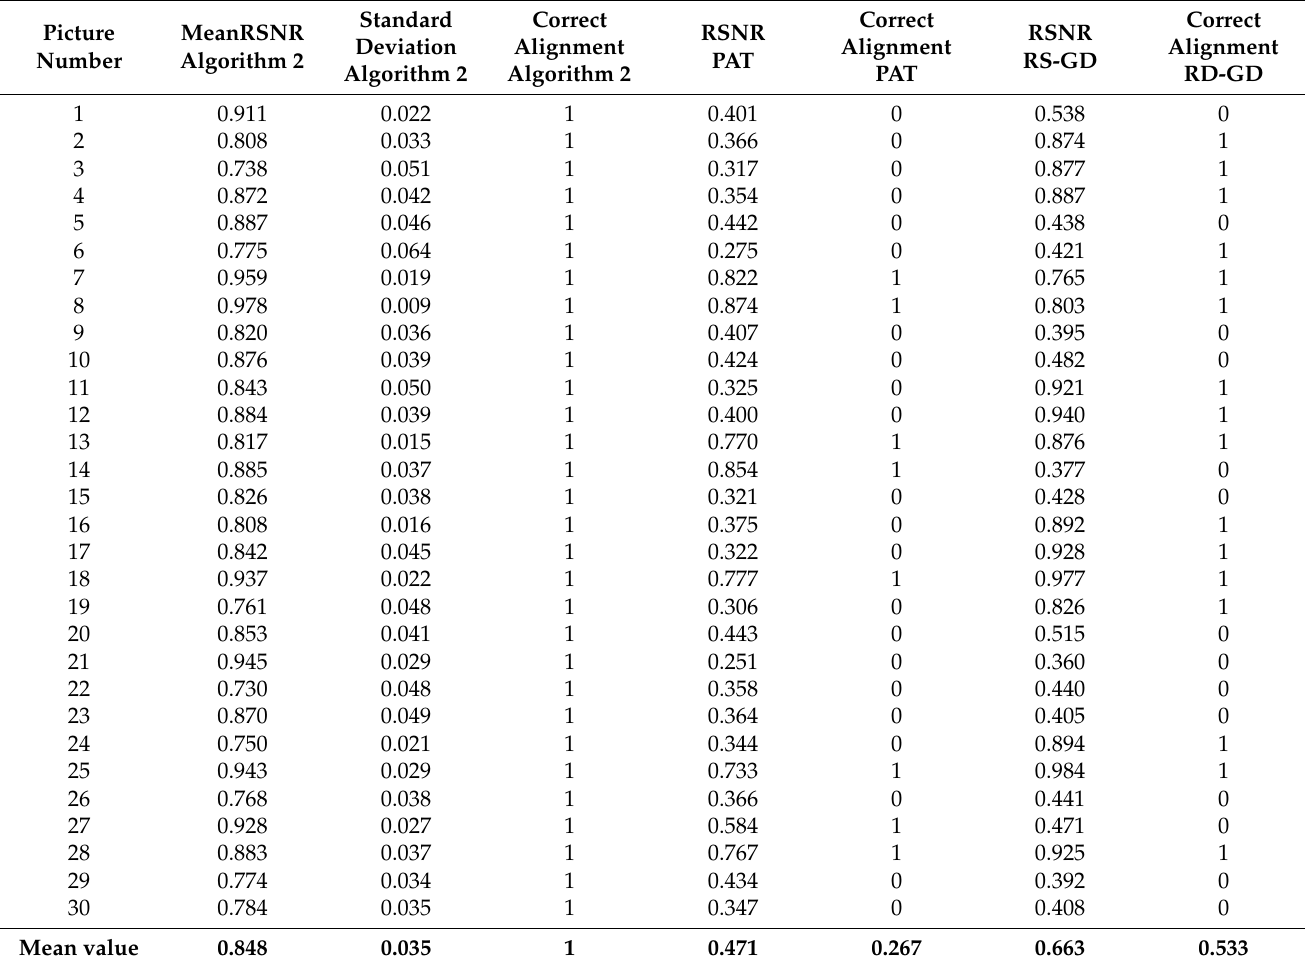
Table 2. RSNR values and success rates – Algorithm 2, PAT and RS-GD.